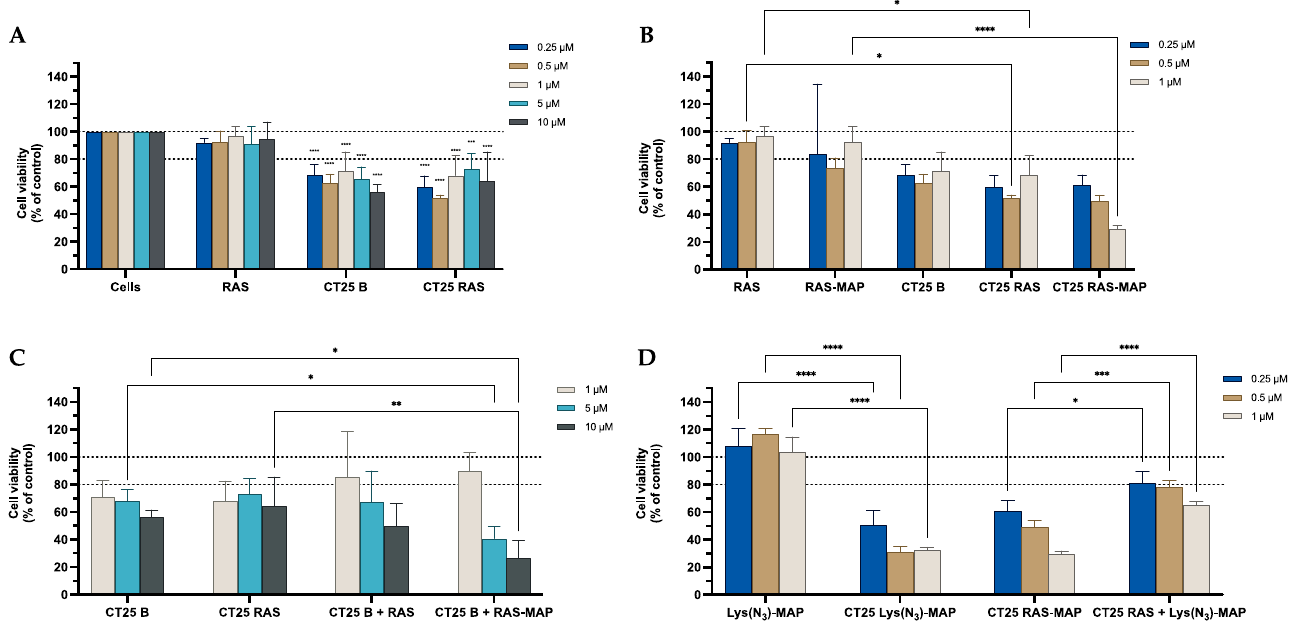
Figure 5. Relative cell viability of Caco-2 cell line measured by the MTT reduction after 24 h incubation. ( A ) Represents NLC safety test with the treatment of free RAS, blank CT25 and RAS-loaded CT25 (0.25–10 µ M). ( B ) Represents differences in the cell viability of treatment with free RAS, RAS-MAP, blank CT25, RAS-loaded CT25, MAP, RAS-MAP-loaded CT25 (0.25–10 µ M). ( C ) Represents co-administration of RAS and RAS-MAP with blank CT25 (1–10 µ M). ( D ) Represents the data obtained from the encapsulation of Lys(N 3 )-MAP and co-encapsulation of RAS and Lys(N 3 )-MAP in the NLC compared with peptide conjugate. Results are expressed as mean ± SD (n = 4 or 6). Statistical analysis between the groups was performed using two-way ANOVA with Tukey’s multiple comparisons test (* p < 0.05; ** p < 0.01; *** p < 0.001; **** p < 0.0001).